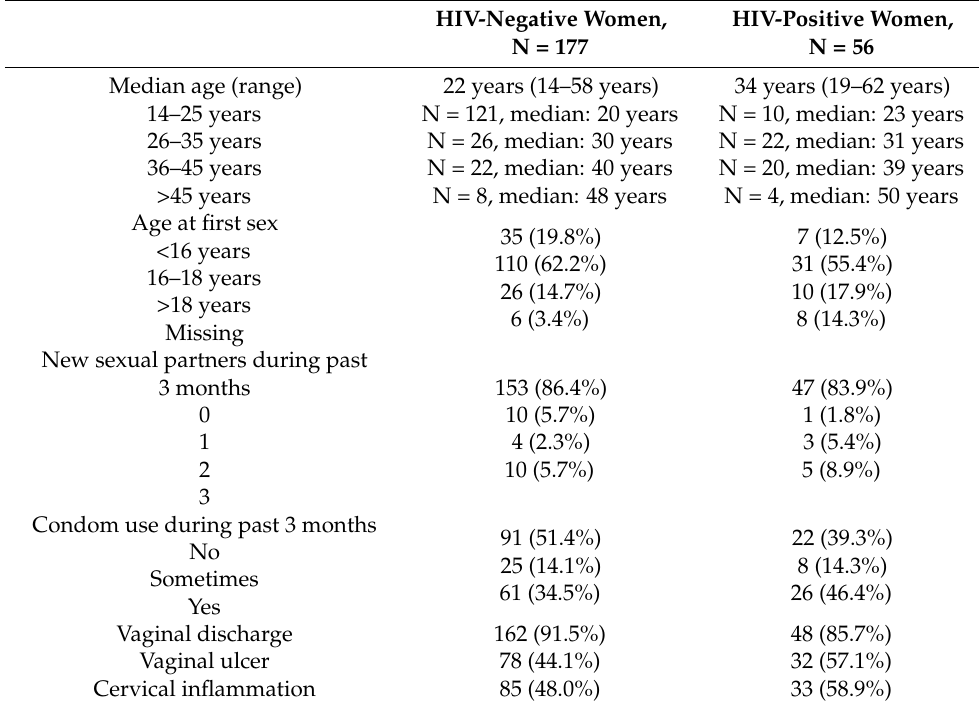
Table 1. Demographic and clinical data of study participants, by human immunodeficiency (HIV)